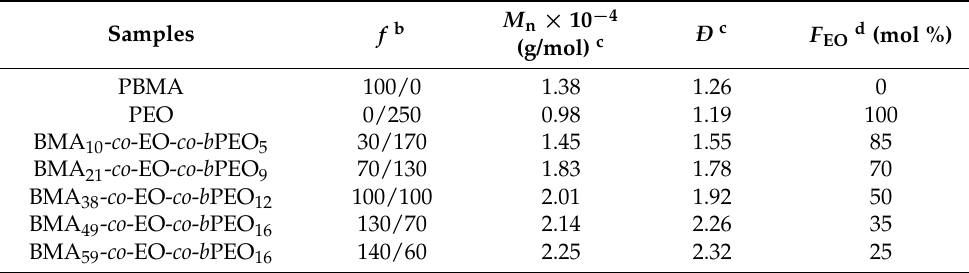
Table 1. Characterization data of BMA and EO (co)polymerization product a .